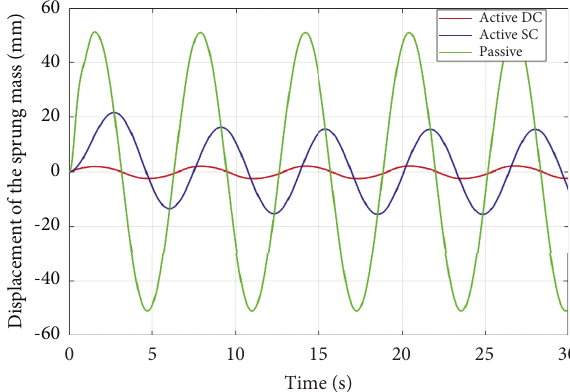
Figure 8: Displacement of the sprung mass.